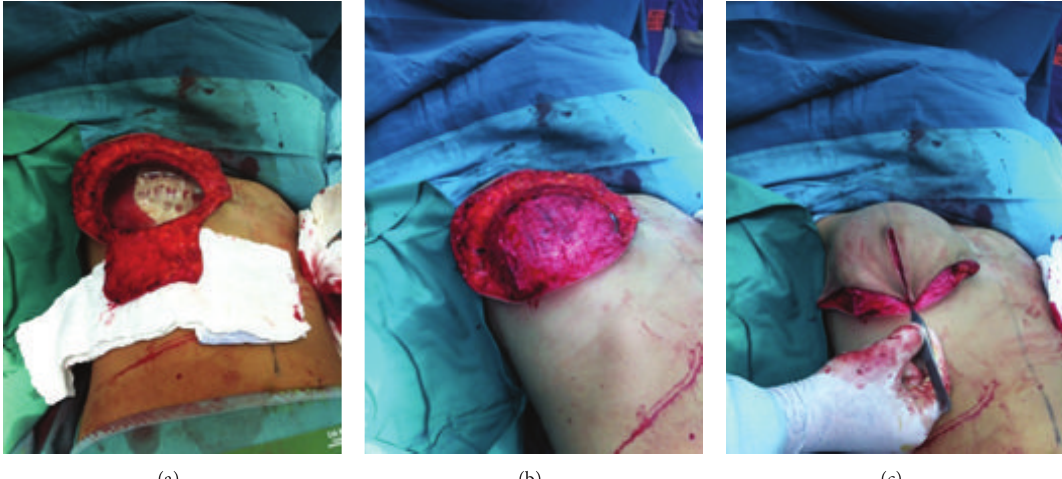
Figure 2: Subpectoral pocket was created; silicone sizer is in a place; IMF-based flap is ready for transfer and lower pole coverage (a); the flap covered the lower pole (b); and the skin envelope is redraped on the totally covered silicone implant (c).